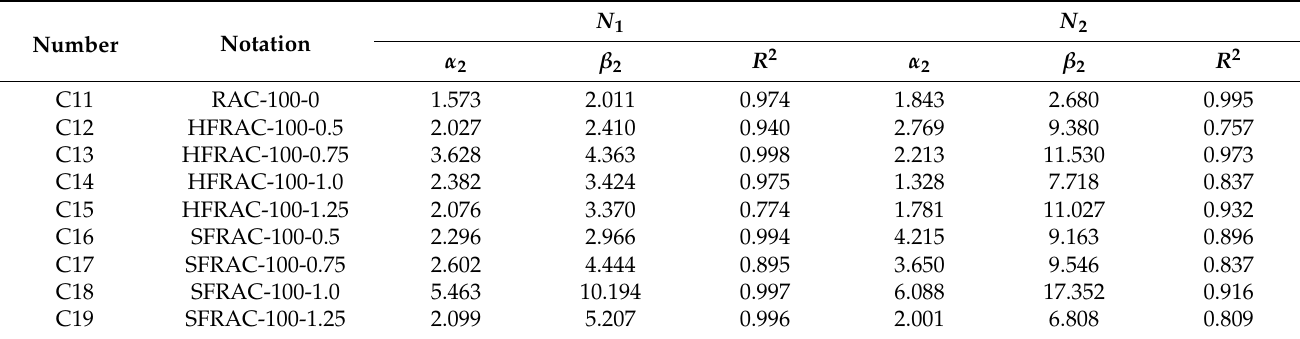
Table 5. Linear fitting results of Weibull